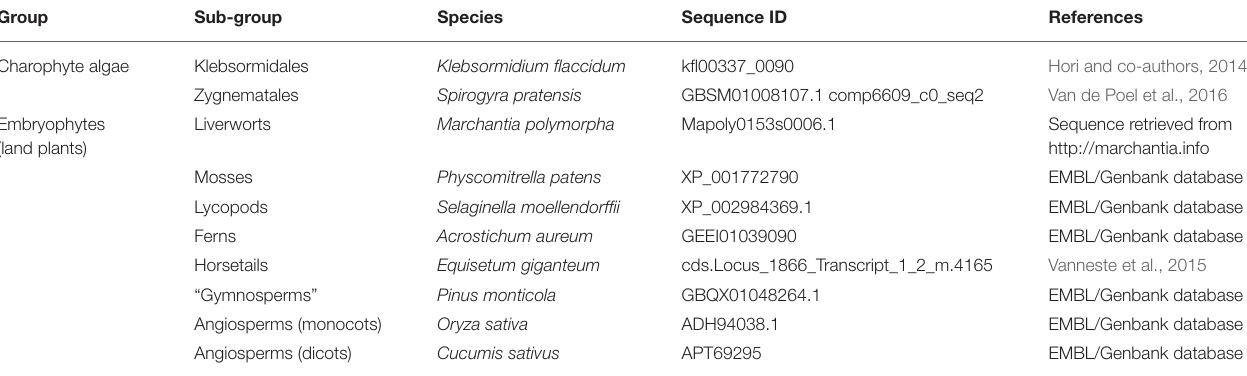
TABLE 1 | Examples of Lsi2-type active Si transporters from across the Charophycae.